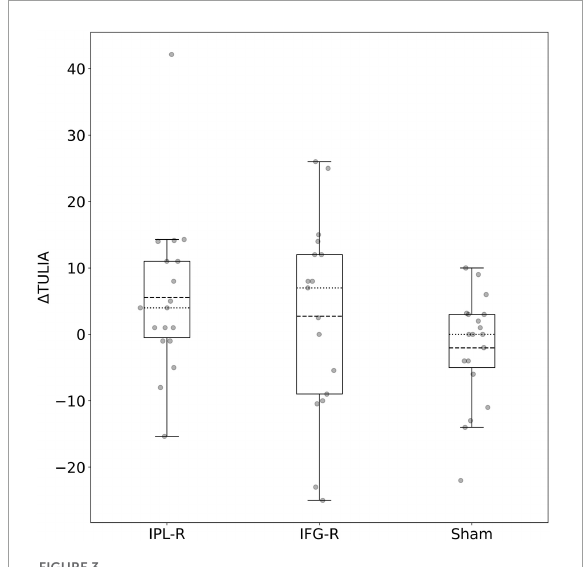
FIGURE3 Boxplot of (cid:49) TULIA after IPL-R, IFG-R and sham stimulation. Dashed line: mean. Dotted line: median.